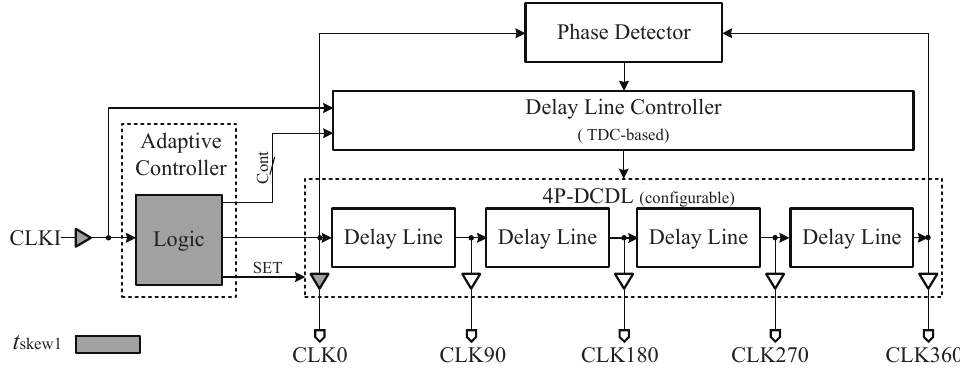
Figure 2. The specific structure of the four-phase